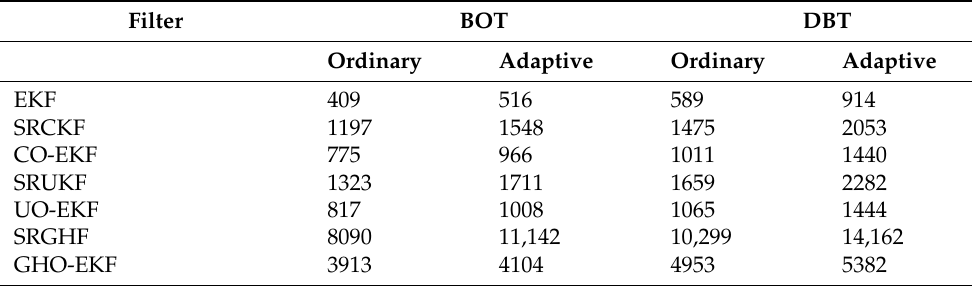
Table 1. Flops count of the implemented filters for BOT and DBT. Filter BOT DBT Ordinary Adaptive